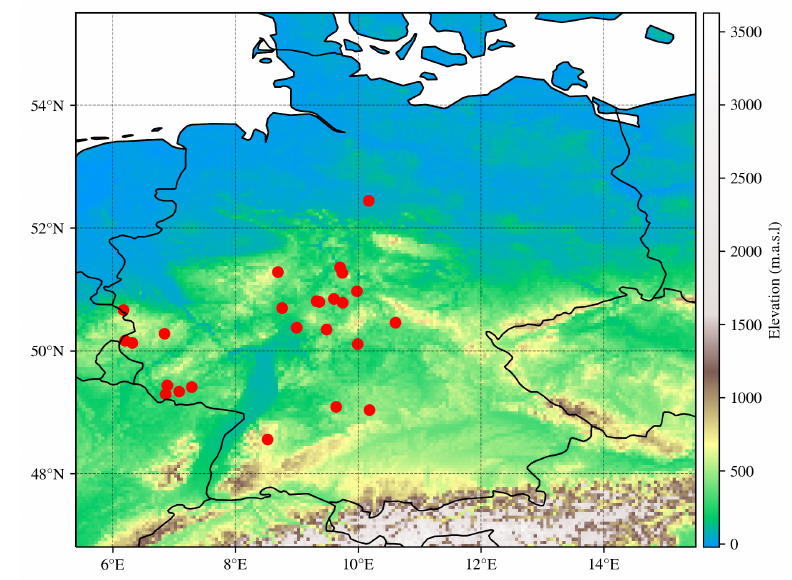
Figure 2. Locations of measurement stations.